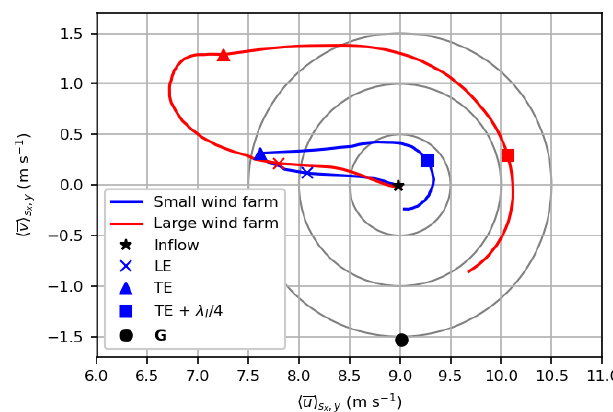
Figure 4. Hodographs of wind speed components u and v along x at hub height. Special streamwise positions are marked: inflow, wind farm leading edge (LE), wind farm trailing edge (TE), one-quarter inertial wavelength downstream of the TE and the geostrophic wind velocity.